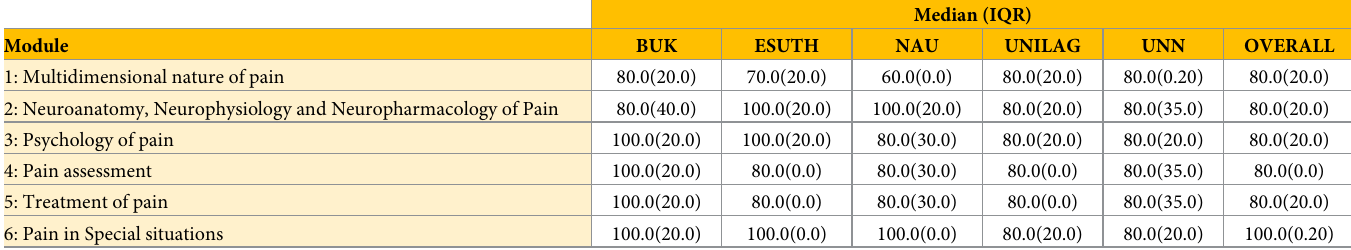
Table 5. Median post-test scores in various modules across schools.